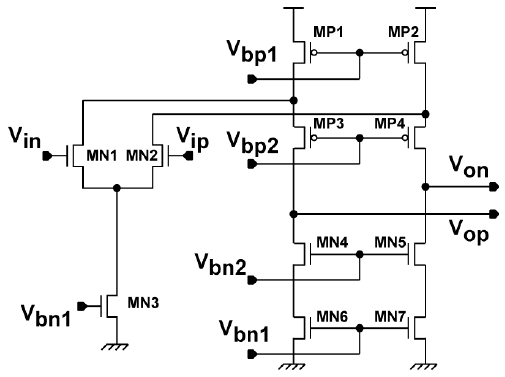
Figure 10. Schematic diagram of the fully differential folded-cascode operational amplifier.